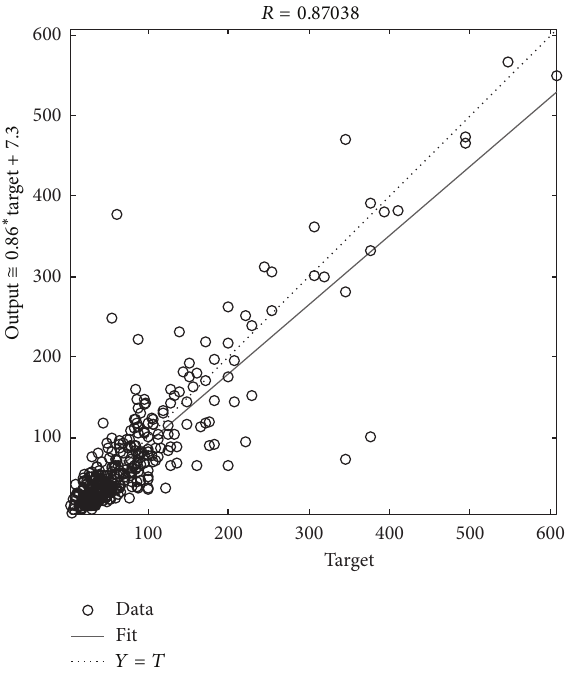
Figure 4: GP steel expression no. 3. Figure 5: GP steel expression no.